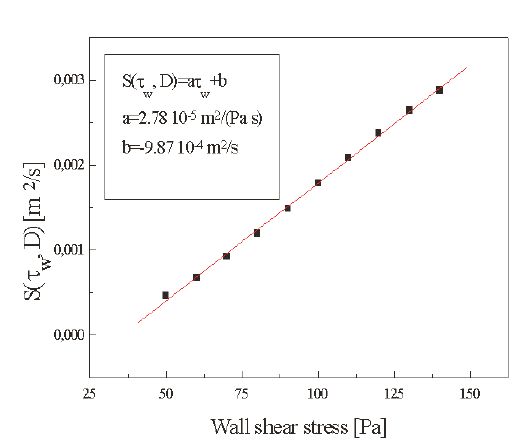
Figure 9 (left): Slip coefficient against wall shear stress for a 0.3% PEO